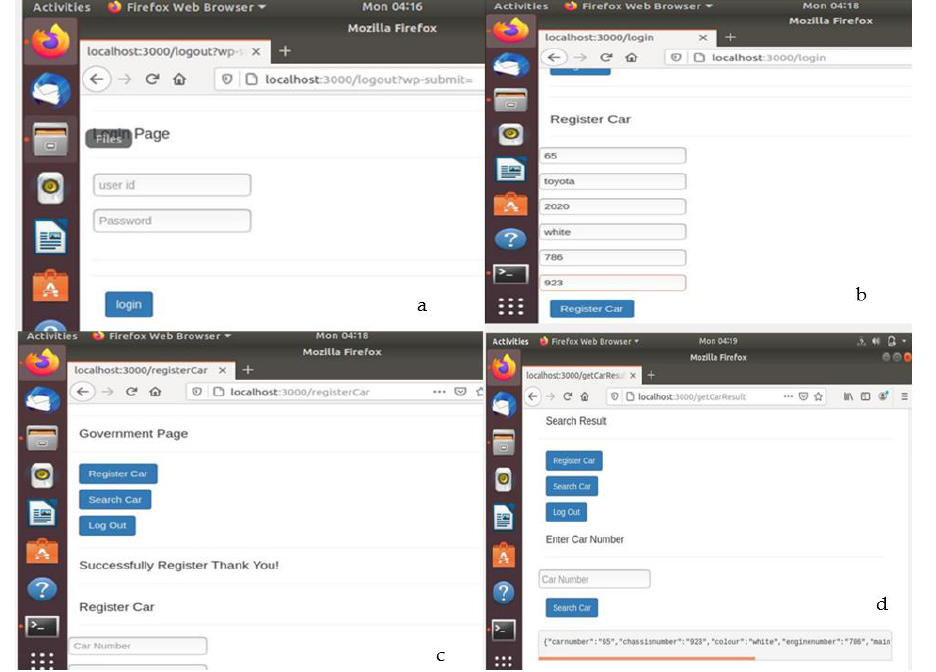
Figure 7. ( a ) User login. ( b ) Car registration interface. ( c ) Successful registration. ( d ) Blockchain successfully created.